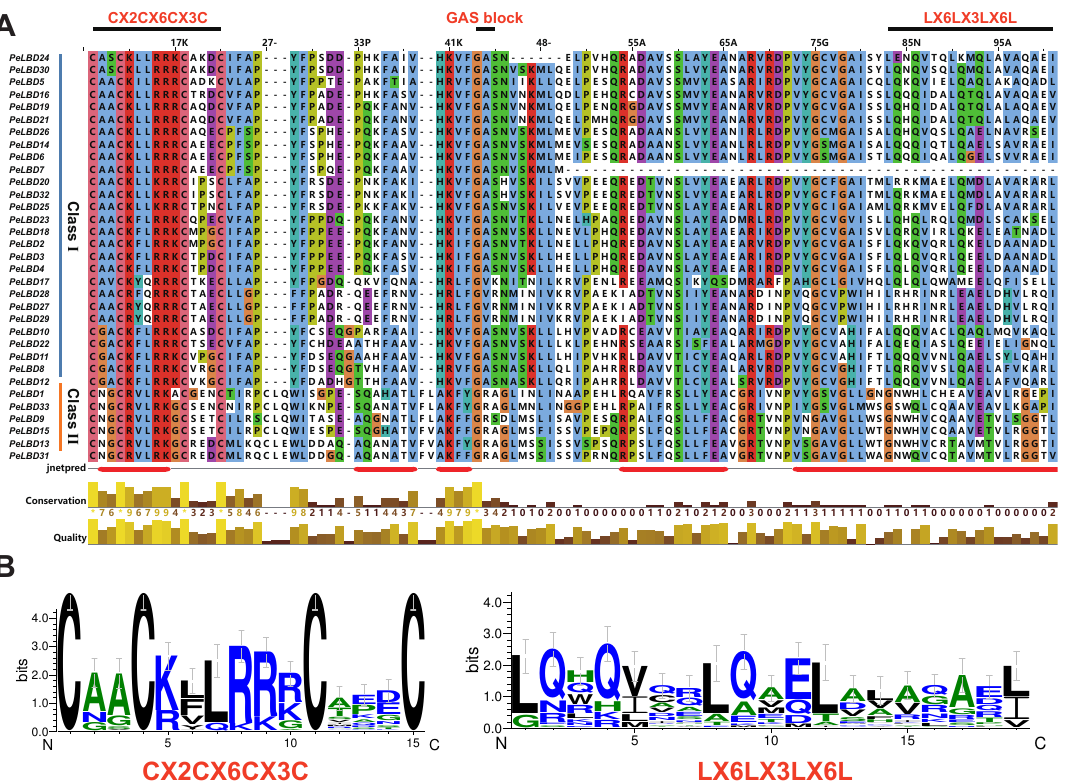
Figure 1. Multiple sequence alignment of the conserved domain proteins of the passion fruit LBD gene family. ( A ) The CX2CX6CX3C zinc finger-like domain was present in all 33 predicted PeLBD protein sequences, whereas the leucine zipper-like motif (LX6LX3LX6L) was present only in the Class I PeLBD proteins; ( B ) Conserved motif logos generated by the WebLogo